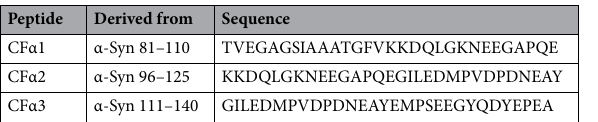
Table 1. Peptides derived from the C-terminal domain of α-Syn.